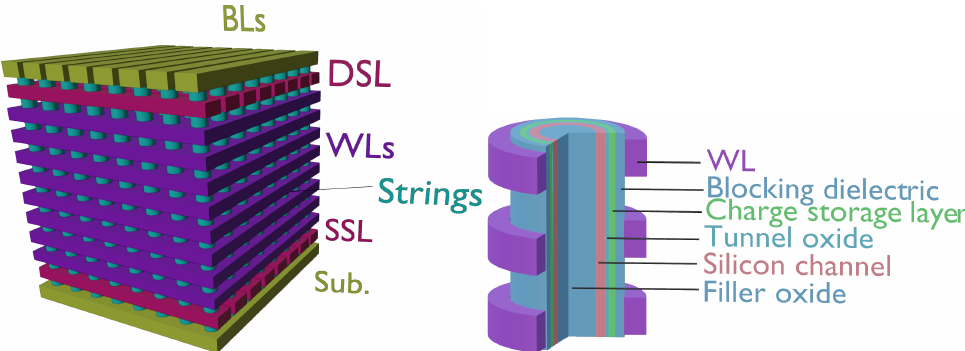
Figure 1. ( Left ) Conceptual view of a vertical-channel 3D NAND array with its main elements (SSL = source select line, WLs = wordlines, DSL = drain select line, BLs = bitlines). ( Right ) pictorial view of an array string highlighting the structure of the elementary memory cells.